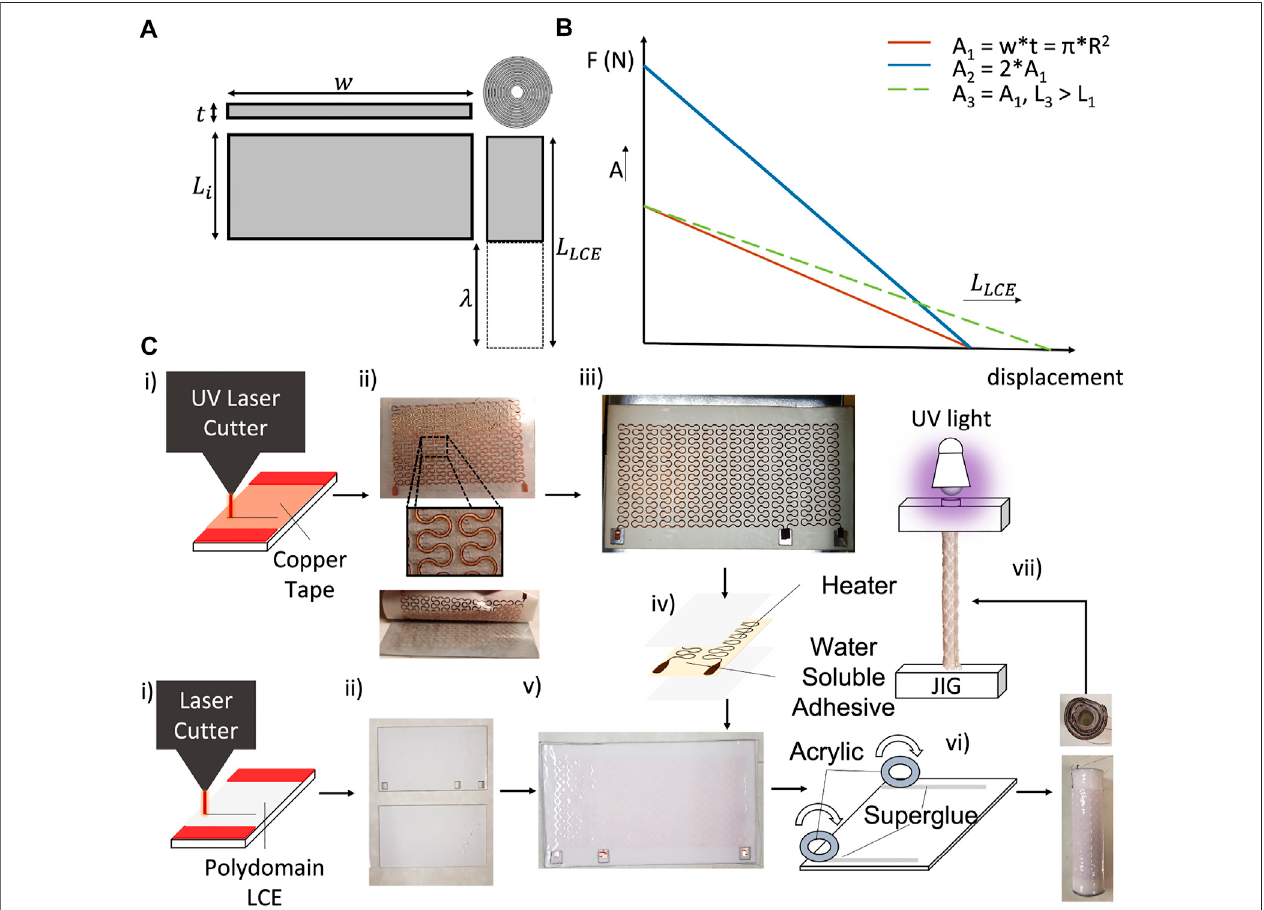
FIGURE 4 | Design guidelines and fabrication process for rolled LCE actuators. (A) Design parameters used to tune the geometry of the LCE, where w is width, t initialthickness. (B) Representativeplotindicating thetunabilityoftherolledactuatorforce-displacementcharacteristic,basedonthedimensions oftheinitialLCEsheet, where A i isthecross-sectionarea,and L 1 , L 2 , L 3 arethelengthsoftheactuator. Y -axisinterceptscorrespondtotheblockedforceofeachactuator,and X -axisintercepts correspond to their corresponding no-load displacements. (C) Process of fabrication of the rolled actuator (from left to right as indicated by arrows): parallel patterningoftheheatersandLCEsheets(withUVandCO 2 lasercutters,respectively),followedbythetransferringprocessofthecircuitontotheLCEsheets,to fi nallyroll and stretch the LCE actuator for alignment.